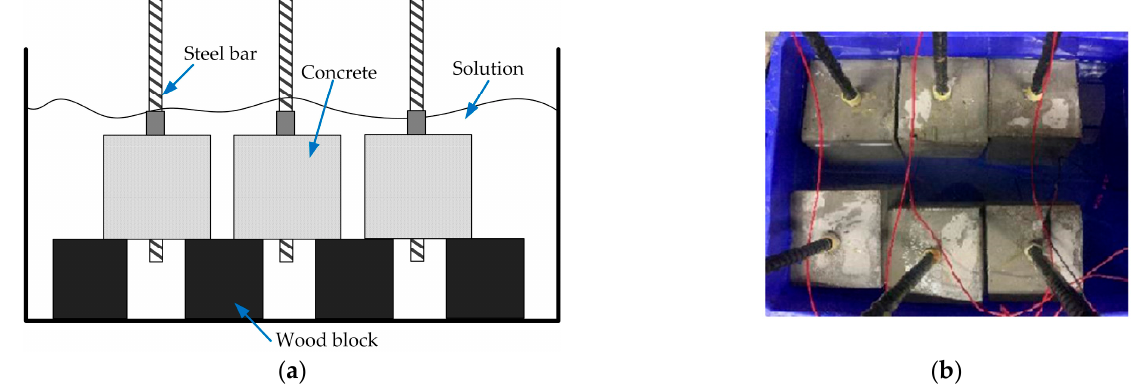
Figure 1. Specimen preparation: ( a ) soaking diagram and ( b ) connection details.